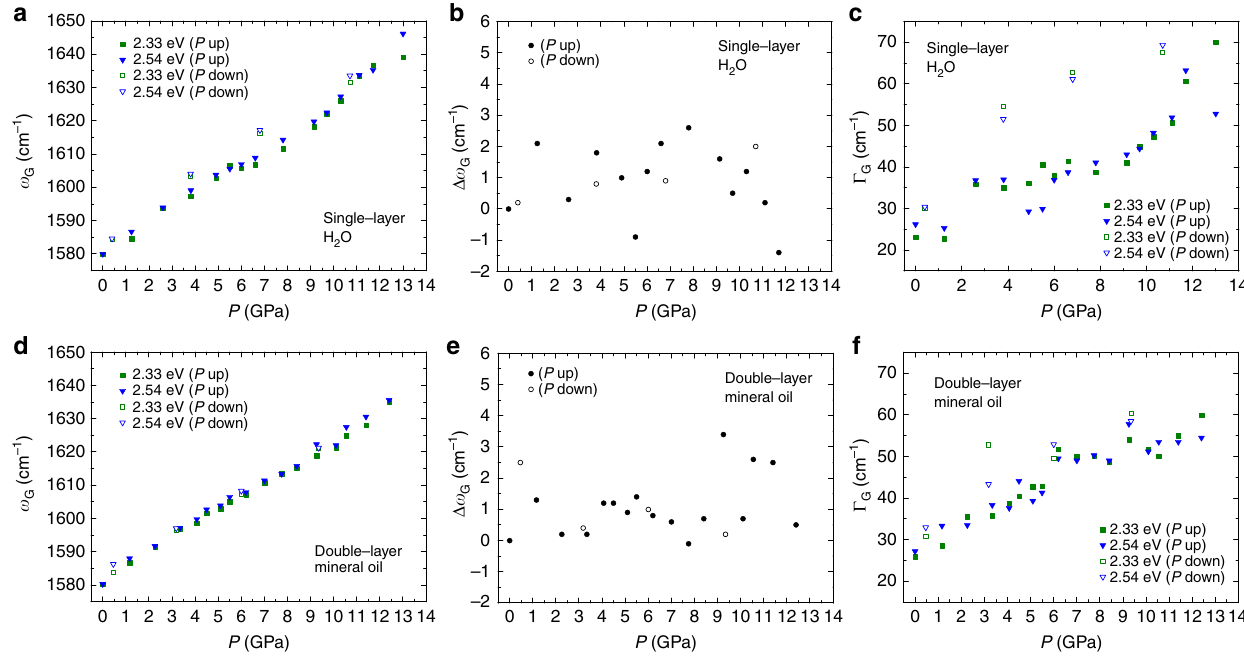
Fig. 6 High-pressure Raman experiments performed in different systems. a – c Single-layer graphene transferred to a Te fl on substrate (G/T) using water as PTM. d – f Double-layer graphene transferred to Te fl on substrate (G/G/T) using mineral oil (Nujol) as PTM. The same experimental procedures as performed for acquiring the data shown in Figs. 1 and 2 were repeated in both cases, and the same notations